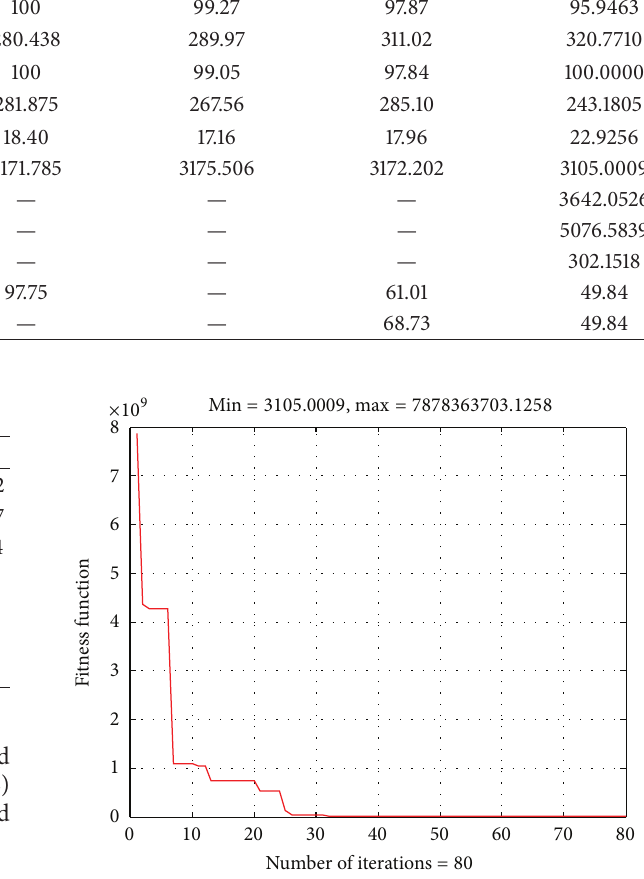
Figure 4: Convergence characteristic of the ABC algorithm for the IEEE 57-bus